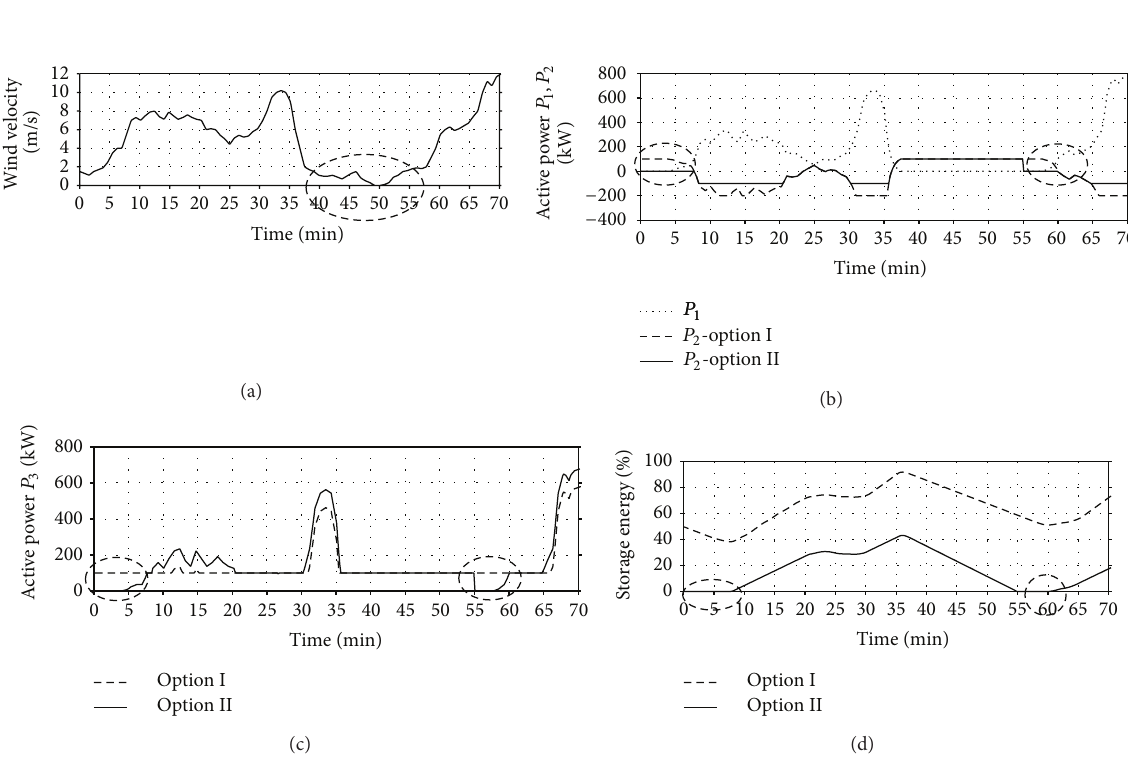
, (b) power 𝑃 1 and 𝑃 2 , (c) power 𝑃 3 , (d) storage loading state 𝐴 WT